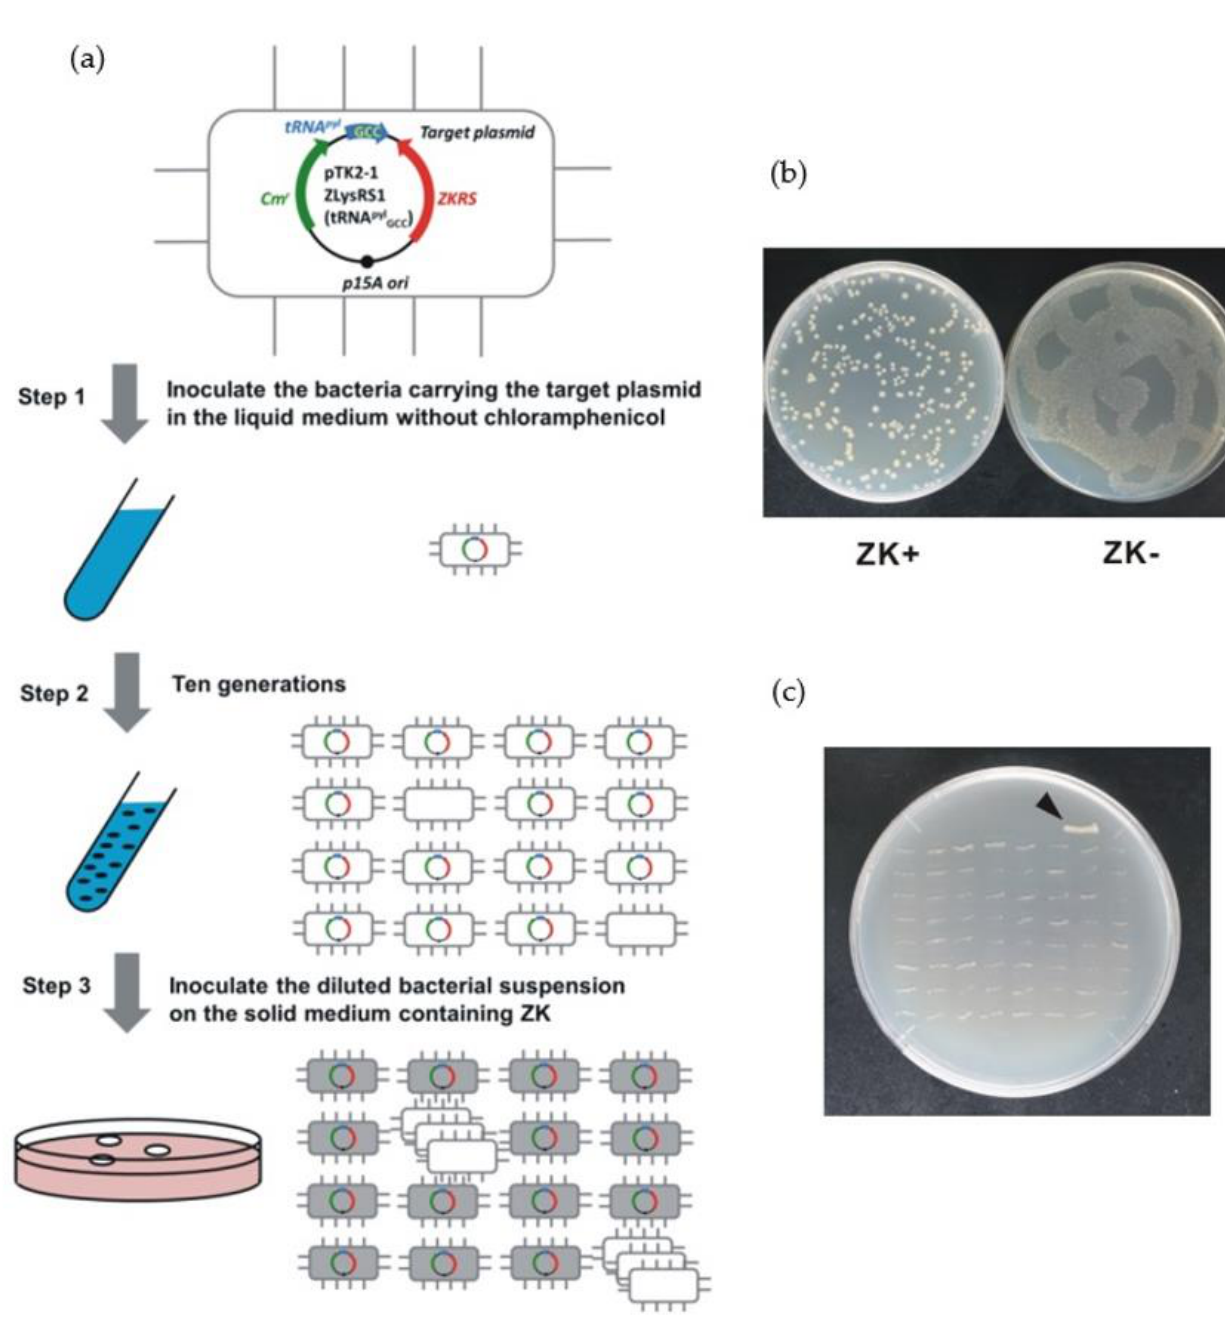
Figure 1. Plasmid curing. ( a ) Schematic diagram of procedure. For detailed experimental conditions, see Materials and Methods. ( b ) Selection of bacteria that lost target plasmid in Step 3. Bacterial culture obtained in Step 2 was diluted and same volume was inoculated as several drops onto solid medium with or without 3 mM ZK. Then, drops were spread by tilting plates. Resulting “twiggy pattern” of fused colonies was an artifact of this incomplete coverage of plate. ( c ) Confirmation of target plasmid loss. Sixty–four colonies obtained in Step 3 were inoculated on solid medium containing chloramphenicol. Parent strain (black arrowhead) carrying target plasmid proliferated, but all 64 of isolates were chlo- ramphenicol – sensitive.